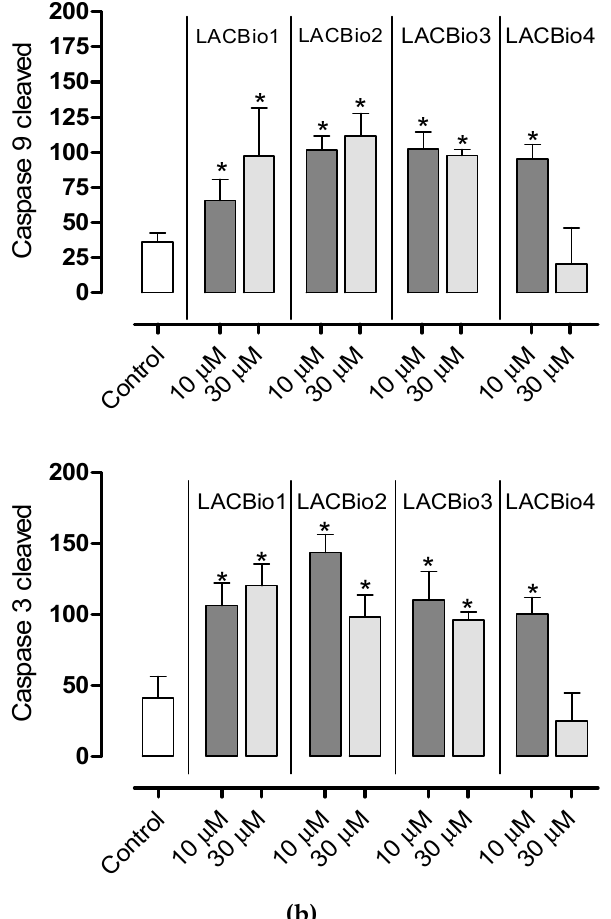
Figure 5. LACBio1, LACBio2, LACBio3 and LACBio4 activate the intrinsic caspase cascade. ( a ) Representative Western blots showing levels of expression of caspase 9, caspase 3 and β -actin. ( b ) Bar graph showing arbitrary unit changes in level of cleaved caspase 9 and 3. All the values are represented as the mean ± standard error of three independent experiments. Statistical analyses were performed using GraphPad Prism 8.02 and included one-way ANOVA with Dunnett ´ s post -hoc test. Statistical significance was defined as * p < 0.05 when compared with the control